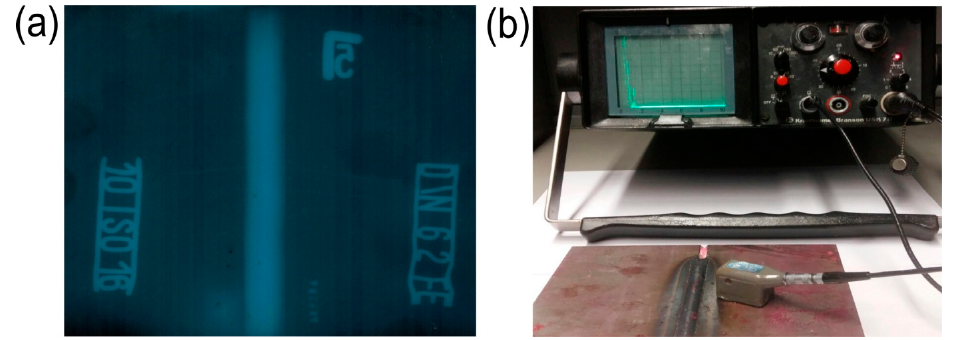
Figure 2. ( a ) X ‐ ray radiograph that shows a weld bead that was analysed. ( b ) Analysis using ultrasonic testing.